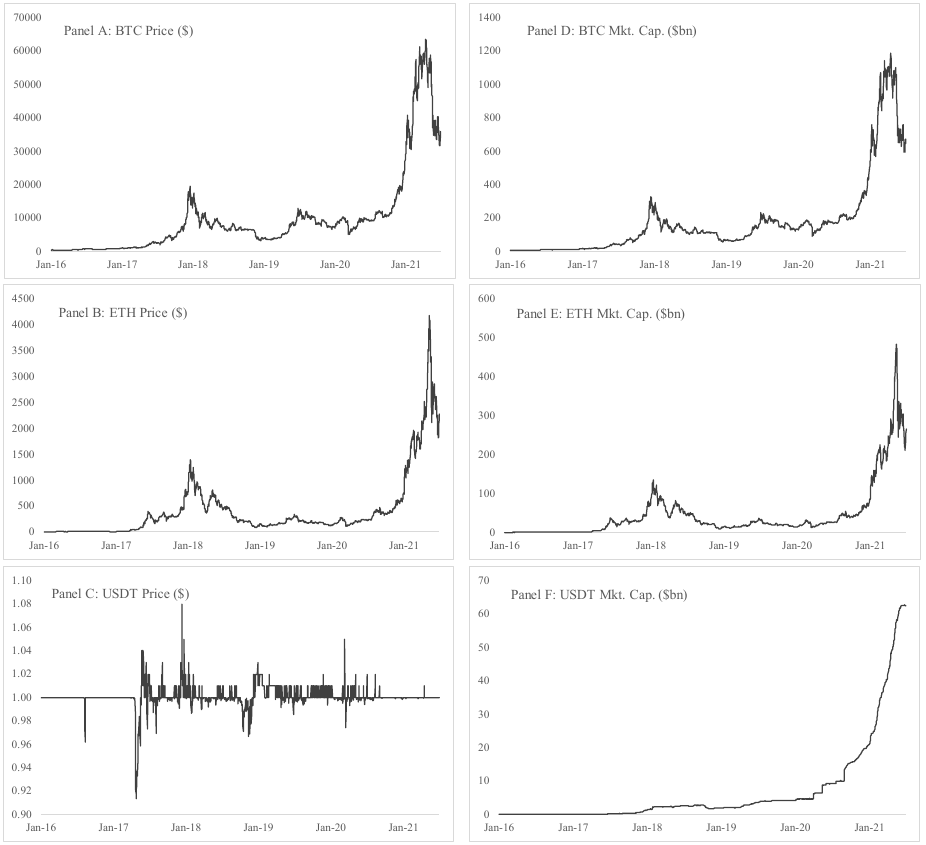
Figure 1. Cryptocurrency price and market capitalisation.